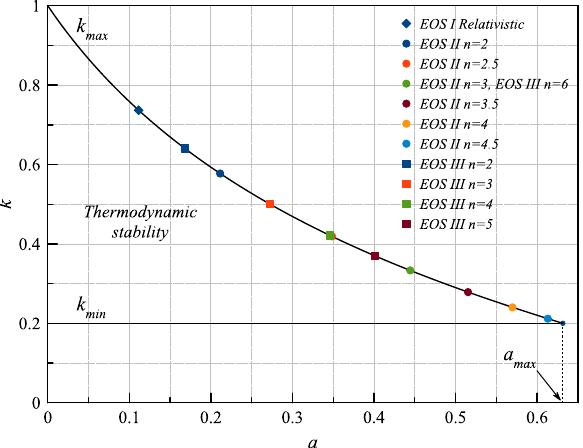
Fig. 9 Dynamic and thermodynamic stability for all the EOS exam- ined here. The states with k < k min = 1 / 5 (which corresponds to a > a max = 12 / 19) violate the DEC. The allowed values of k for ther- modynamic stability are those below the k max ( a ) curve, determined by Eq. 53, and above k min . The allowed values of k for dynamical stability are those above the value of k on the curve for each EOS, which corre- sponds to the value of k m ∗ of the maximum of the curve m ∗ for each